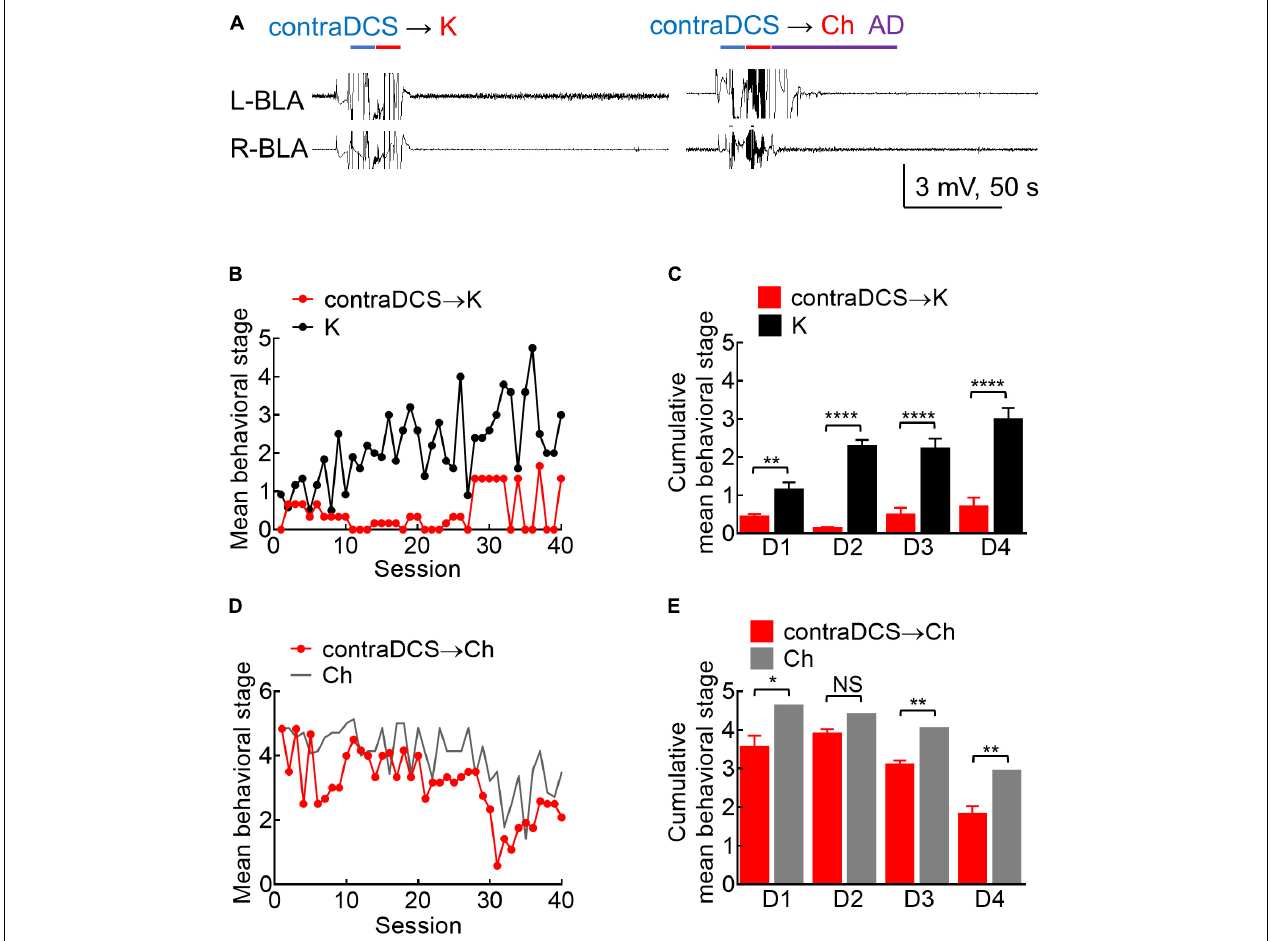
FIGURE 8 | Effects of contralateral DCS if given right before the kindling or the challenge stimuli. (A) Sample local field potentials (LFP) show that contralateral 100 µ A, 10-s DCS at right basolateral amygdala (R-BLA) right before kindling (contraDCS → K, left) or challenge (contra DCS → Ch, right) markedly suppresses AD (and the rat expressed no seizure behaviors). (B) Contralateral 100 µ A, 10 s DCS at R-BLA immediately before the kindling stimuli applied to the left BLA (L-BLA) (contraDCS → K, red symbols, n = 3; K, black symbols, n = 6) markedly lowers the mean behavioral stage when compared to the kindling the only group. Only the mean values are shown [standard error of the mean (SEM) is omitted for the sake of clarity]. (C) Cumulative mean behavior seizure stages in each of the 4 days are in general lower with contralateral DCS when compared to the kindling only groups ( n = 10, 10 each day from the mean of 3, 6 rats for contraDCS → K and K group, respectively). (D) Contralateral DCS at R-BLA right before the challenge stimuli in fully kindled rats (contraDCS → Ch, red symbols, n = 6) also lowers the mean behavioral stage when compared to the challenge-only group (gray line, data taken from Figure 3B with the symbols omitted). Only the mean values are shown [standard error of the mean (SEM) is omitted for the scale of clarity]. (E) Cumulative mean behavior seizure stages in each of the 4 days are in general lower with contralateral DCS when compared to the challenge-only groups ( n = 10, 10 each day from the mean of 6, 7 rats for contraDCS → Ch and Ch group, respectively). NS p ≥ 0.05; * p < 0.05; ** p < 0.01; *** p < 0.001; **** p < 0.0001, Mann–Whitney U